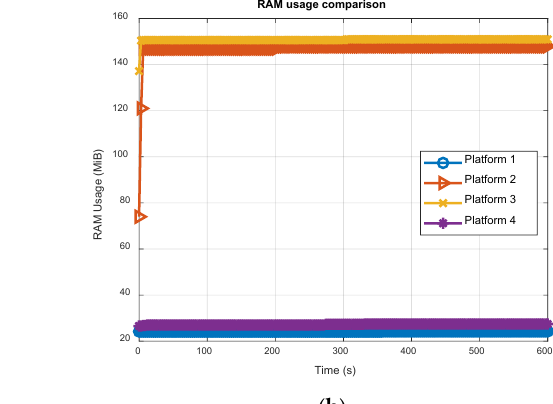
Table 11. CPU and RAM usage summary.